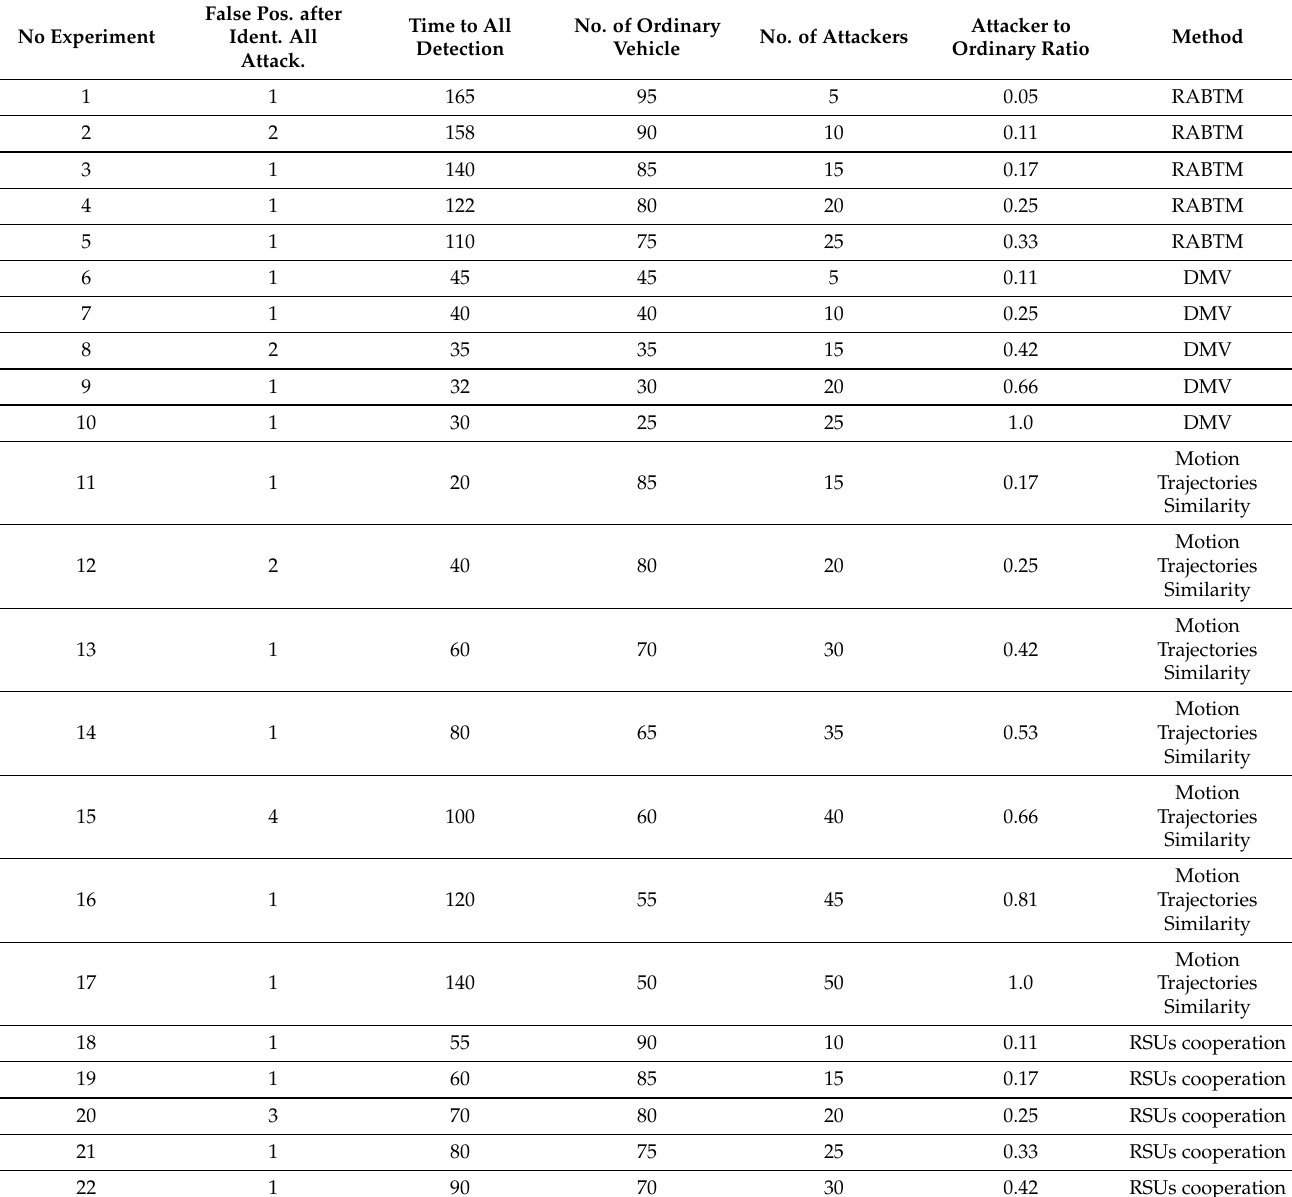
Table 8. Results obtained by the authors of [19,32,34,37,40,41,43,45,46]; the research works examined papers in order to conduct the same experiments that were tested and presented in Table